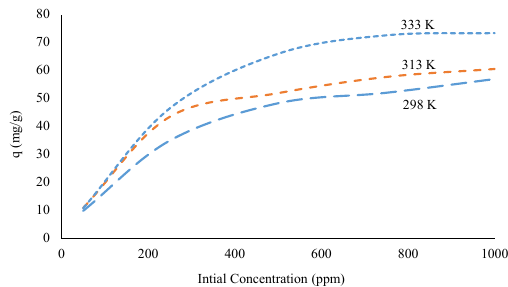
Fig. 4. Effect of initial concentration on the amount sorbet of Cd(II) ions onto natural zeolite at different temperatures